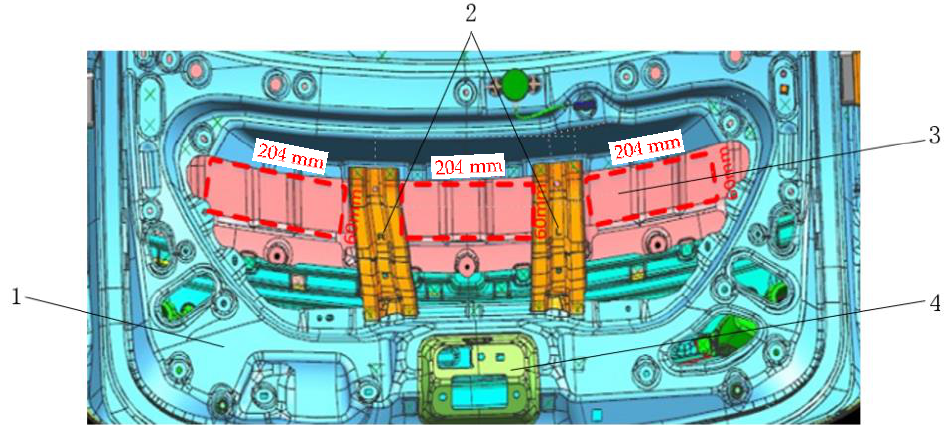
Figure 15. Installation position of acoustic metamaterial (red dotted box).